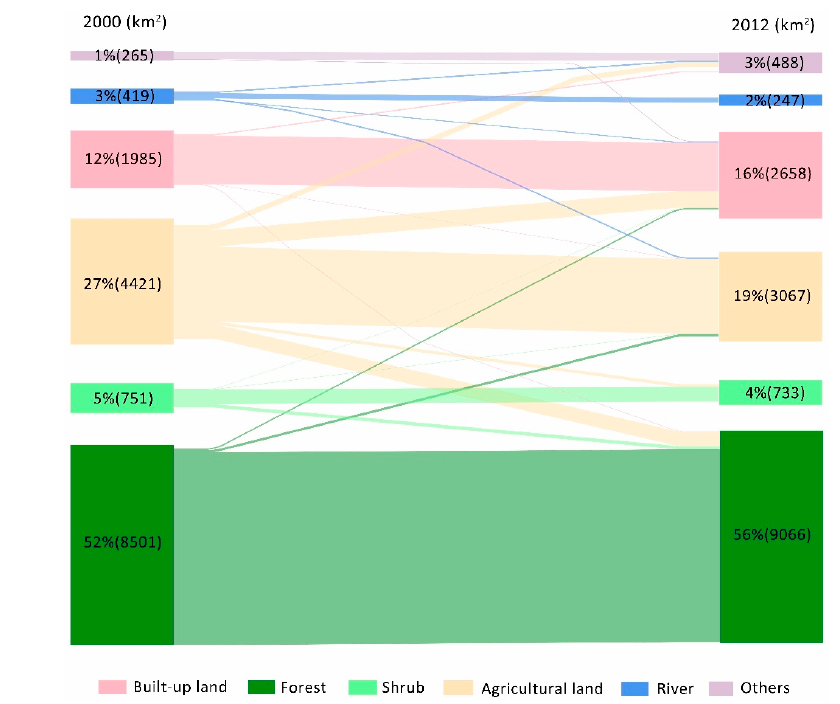
Figure 3. Area change of different land-use types from 2000 to 2012.